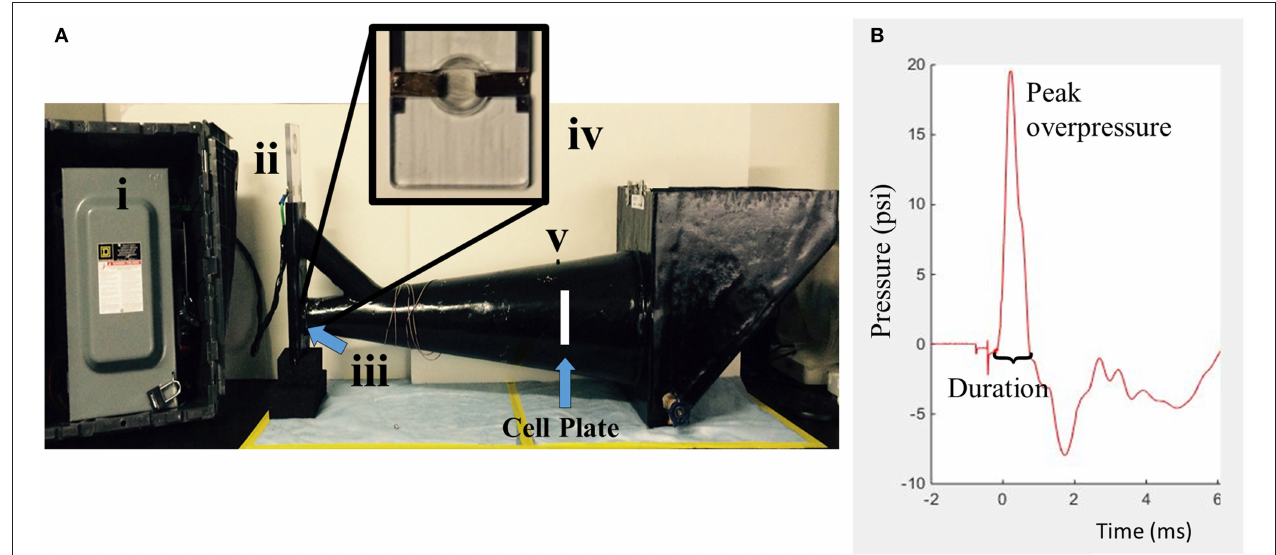
FIGURE 2 | The HOS is a water-filled chamber which exposes in vitro samples to high-rate overpressure via an exploding bridge wire mechanism. (A) The generator is composed of four main parts. (i) Capacitor (ii) Circuit mechanism (iii) Wire bridge (inside) (iv) Wire bridge (zoomed) (v) Piezo transducer. (B) The simulated high-rate overpressure profile is designed to mimic intracranial pressure traces from in vivo blast testing.